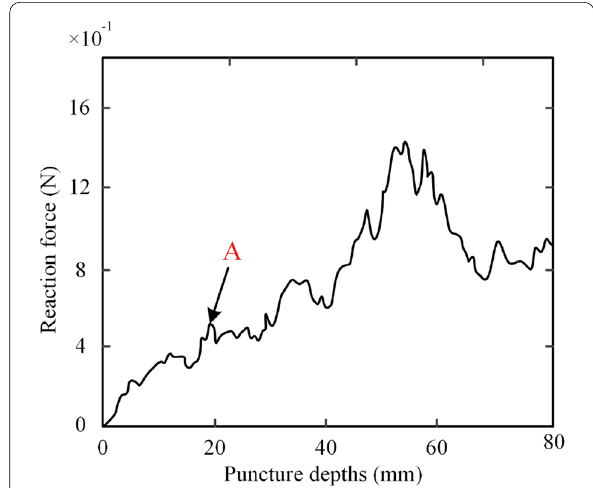
Figure 12 Reaction force of puncture needle at different puncture